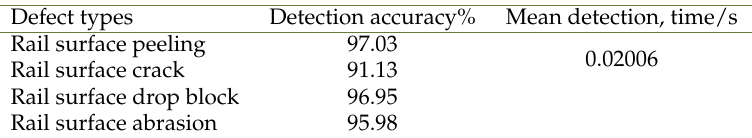
Table 5. The detection result of four defects with proposed algorithm.